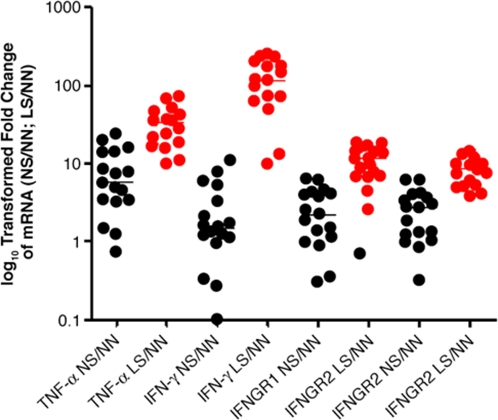
Changes in expression of TNF-α, IFN-γ, and IFN-γ receptors.Relative expression of mRNA and median fold changes of in lesional skin (LS), or nonlesional skin (NS) compared with skin from healthy donors (NN) are shown. The averages of the relative mRNA levels of these cytokine and their receptors in NN from 2 donors were scaled to 1 based on TaqMan QRT-PCR assays. The horizontal bars represent the median fold change. Black points: the relative fold change of mRNA in NS compared with NN; Red points: the relative fold change of mRNA in LS compared with NN. The P values for the overexpression of these individual genes in NS or LS compared with NN (listed in pairs) are as follows: IFN-γ, 0.02, <0.001; IFNGR1, <0.001, <0.001; IFNGR2, <0.001, <0.001; TNF-α, <0.001, <0.001, respectively.